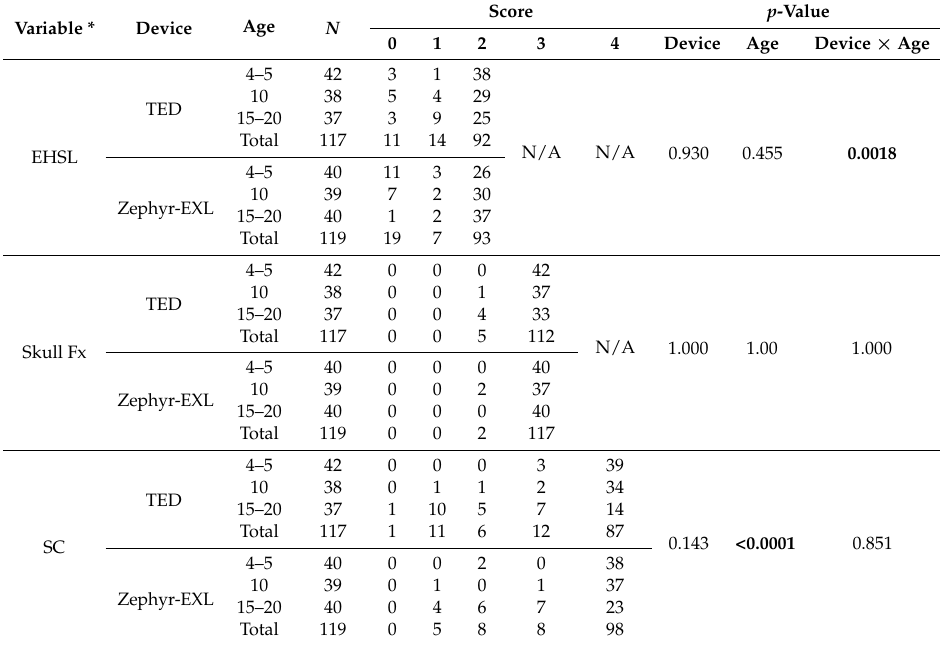
Table 7. Distribution of macroscopic hemorrhage scores following application of the Turkey Euthanasia Device (TED) and